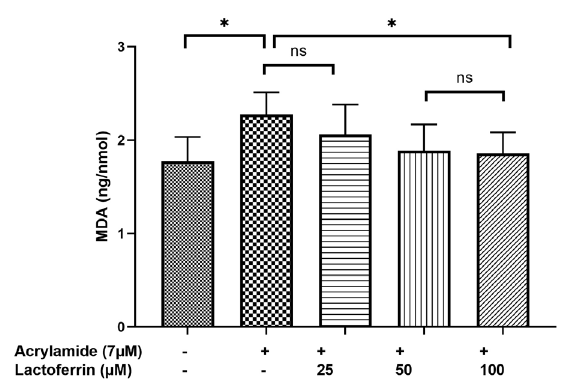
Figure 2. Protective effect of lactoferrin on lipid peroxidation against acrylamide-induced oxidative stress in HepG2 cells. The results were shown with mean±standard deviation. ns: not significant * p < 0.05.